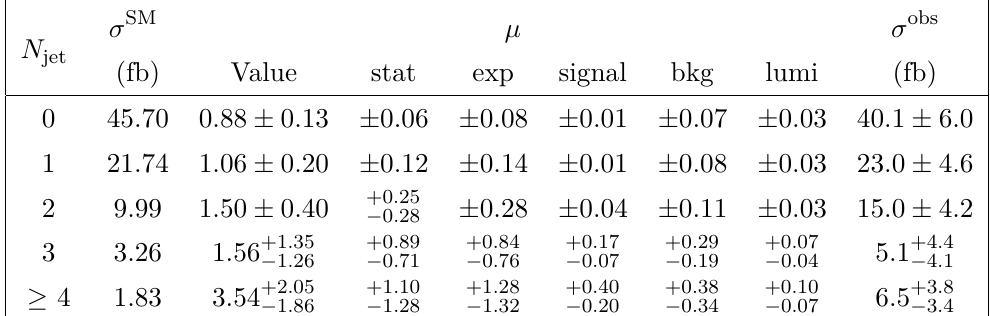
Table 7 . Observed signal strength modifiers and resulting cross sections in fiducial p H cross section values are the products of σ SM and the regularized µ . The total uncertainty and the contributions by origin are given, where the contributions are statistical (stat), experimental excluding integrated luminosity (exp), theoretical related only to signal modeling (sig), to the background modeling (bkg), and integrated luminosity (lumi). Estimated biases in regularization are separately listed in the second from last column and are not included in the total uncertainty.